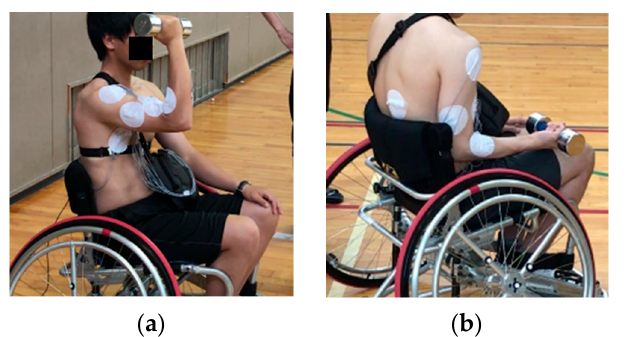
Figure 2. Measurement position of sEMG and schematic diagram I: ( a ) five measurement points and ( b ) schematic diagram of the experiment.